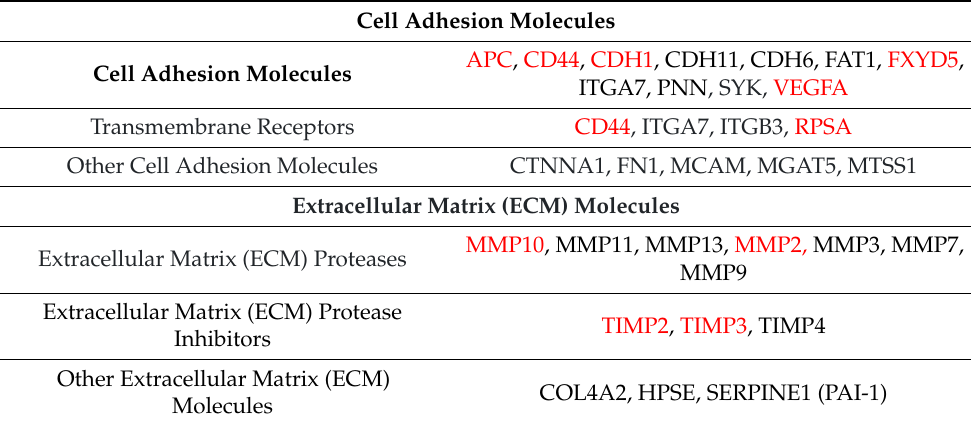
Table 1. List of genes analyzed using Human Tumor Metastasis PCR Array (Qiagen, Hilden, Ger- many). Genes which showed a statistically significant significance in the results obtained were marked in